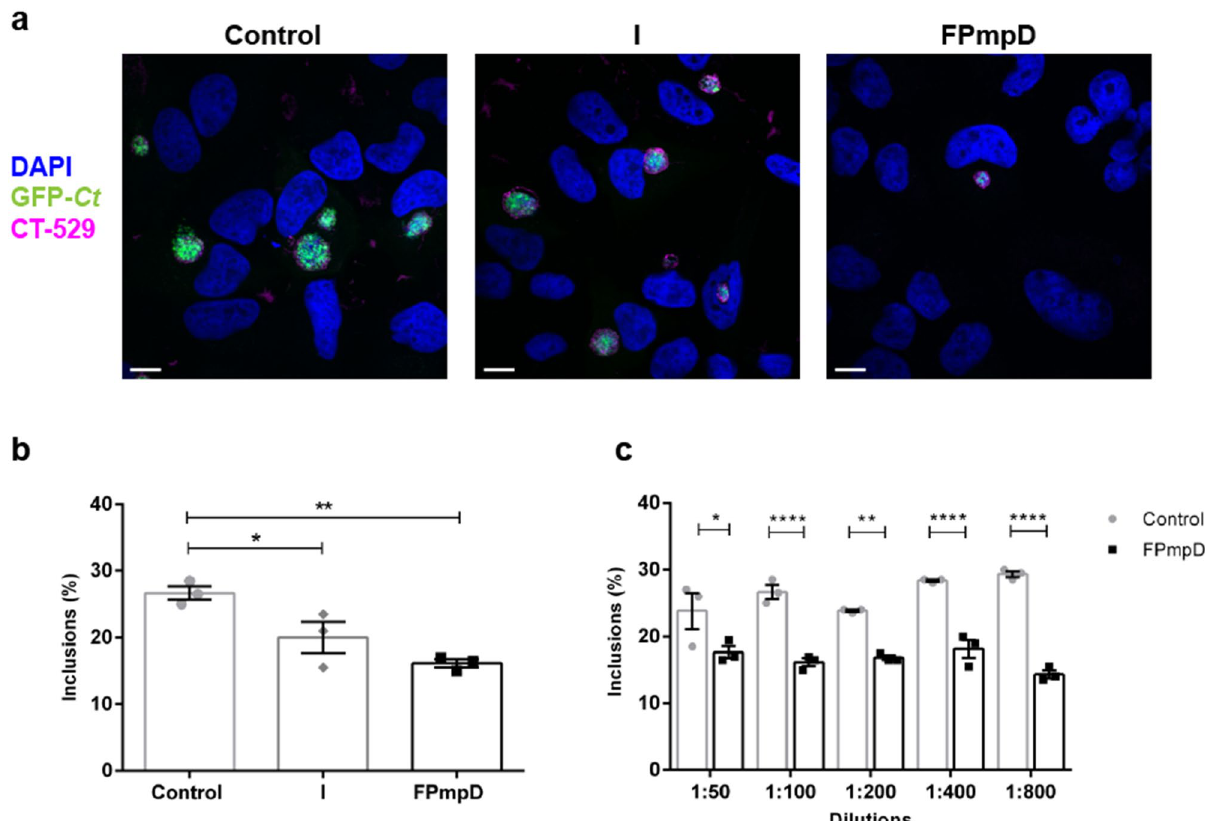
Figure 4. In vitro neutralization assay. ( a ) Confocal images of HeLa cells infected with GFP- Ct previously incubated with sera from non-vaccinated uninfected (Control), non-vaccinated infected (I), and FPmpD- vaccinated uninfected (FPmpD) mice. Nuclei were labeled with DAPI, chlamydial inclusion membrane were detected with anti-CT-529 antibodies, and bacteria expressed the green fluorescent protein (GFP- Ct ). Bar represents 10 µm. ( b ) Quantification of the number of GFP- Ct inclusions by confocal microscopy. Each dot represents the mean of each group evaluated by triplicates. At least 540 cells were evaluated for each replication and experimental condition. Results are expressed as number of inclusions per 100 cells (%). Bars indicate means ± SEM for each experimental group (one-way ANOVA; Dunnet post-test; *p < 0.05; **p < 0.01). ( c ) Number of GFP- Ct inclusions developed in the presence of different dilutions of sera from non-vaccinated uninfected (Control) and FPmpD-vaccinated uninfected (FPmpD) mice. Each dot represents the mean of each group evaluated by triplicate. Six different fields were counted for each replication and condition. Results are expressed as number of inclusions per 100 cells (%). Bars indicate means ± SEM for each experimental group (1:50, 1:100, 1:200, 1:400, 1:800 dilutions; Mann–Whitney; *p < 0.05; **p < 0.01; ****p <